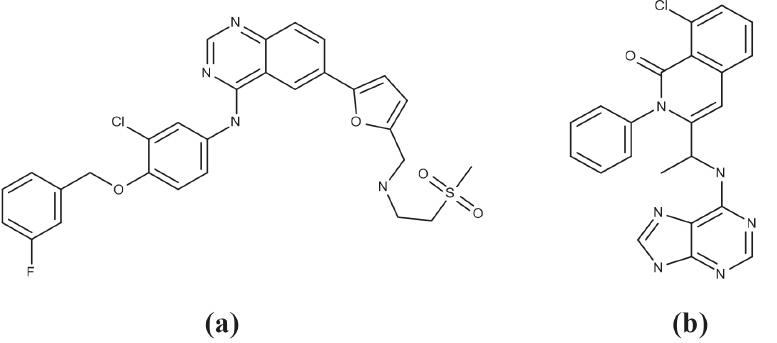
FIGURE 2 - Lapatinib (a), Duvelisib